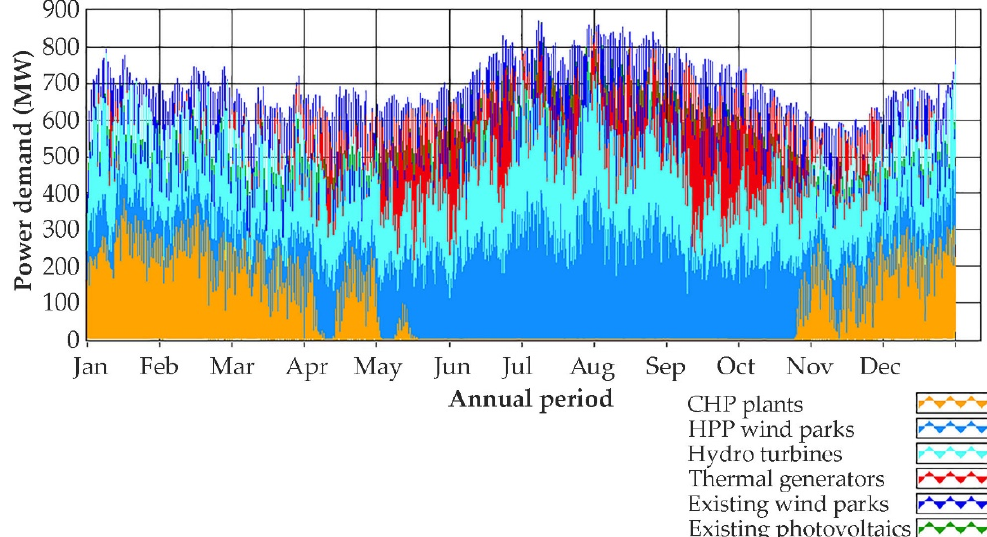
Figure 27. Synthesis of the annual power production in Crete with all the investigated technologies.